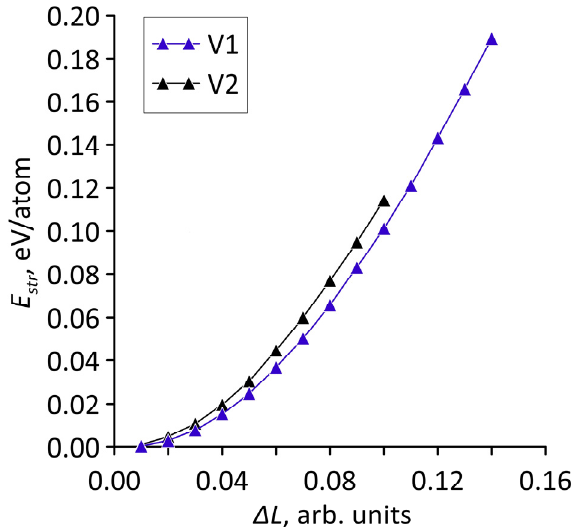
Figure 4. Dependence of the strain energy of bilayer graphene-SWCNT (12,6) hybrid films on the magnitude of stretching in relative units for supercells of topological models V1 and V2.